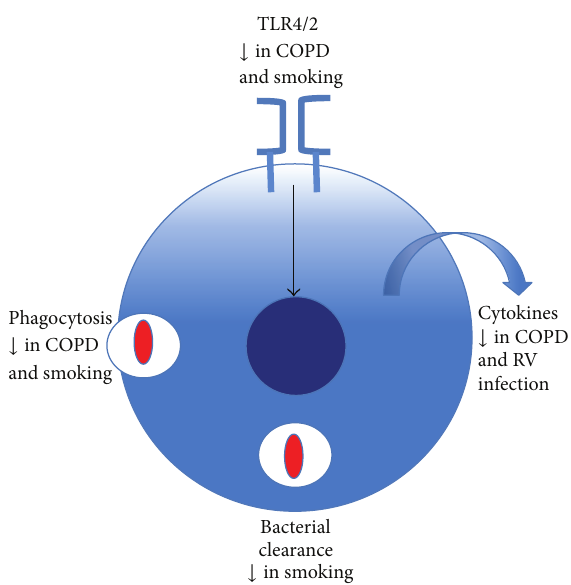
Figure 2: Factors associated with impaired macrophage immune responses to NTHi. There are some important factors that inhibit the lung macrophage response to NTHi infection. Macrophage activation through TLR4 and 2 is impaired in patients with chronic obstructive pulmonary disease (COPD) and by smoking. Phagocy- tosis is reduced in patients with COPD; smoking also inhibits this process as well as bacterial clearance. Macrophage effector function with cytokine production is impaired in subjects with COPD and by rhinovirus (RV)